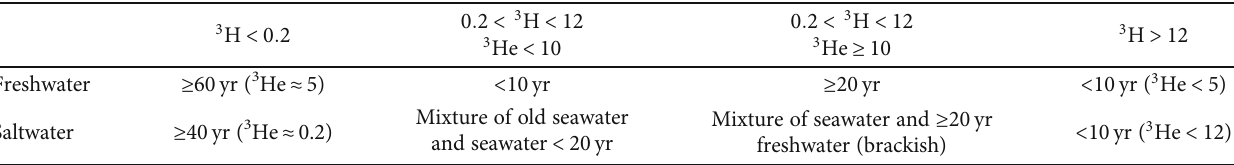
Table 2: Time since recharge for freshwater and seawater depending on groundwater 3 H and 3 He concentration (all numbers in TU) for simulation A7 with α L = 5m